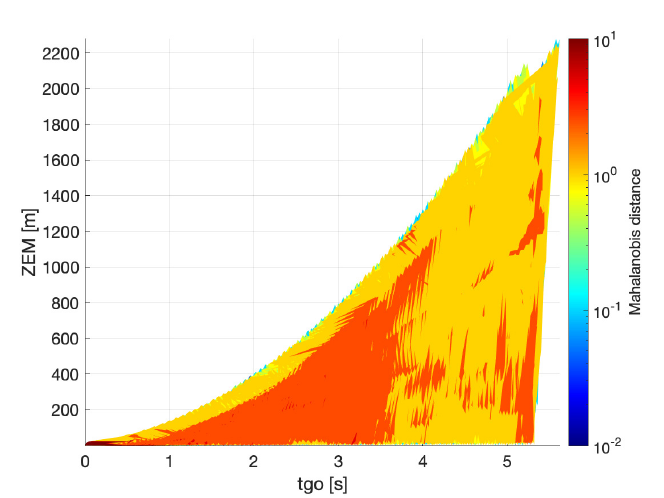
Figure 6. d M ( ZEM ) from the filter—Bearings + Range